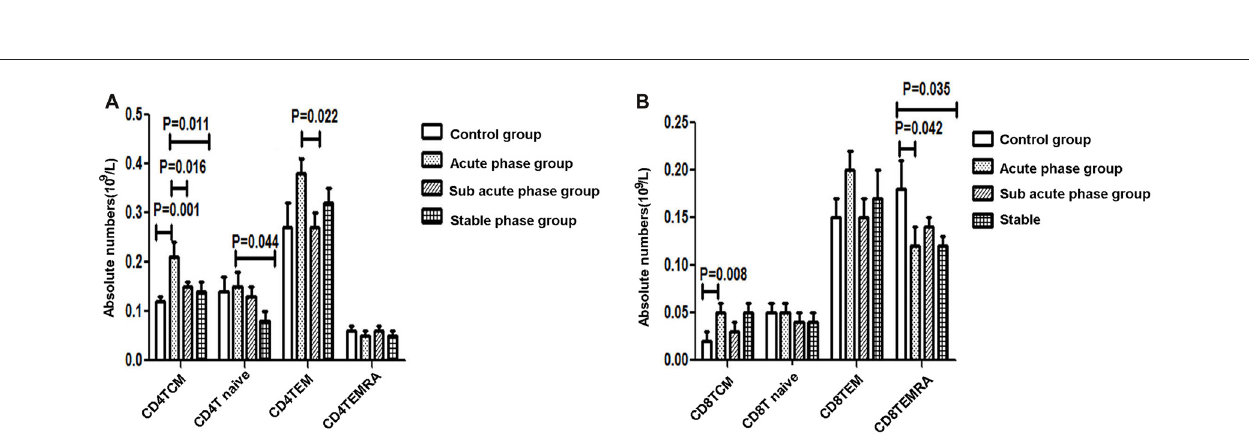
FIGURE 2 | Absolute numbers of T cells, B cells and NK cells in ischemic stroke groups and the control group (comparisons between groups were performed via one-way analysis of variance (ANOVA), and a post hoc test was used to determine differences between groups. Graphs show the mean + SEM; Control group ( n = 14), Acute phase group ( n = 18), Sub-acute phase group ( n = 31), Stable phase group ( n = 15)).